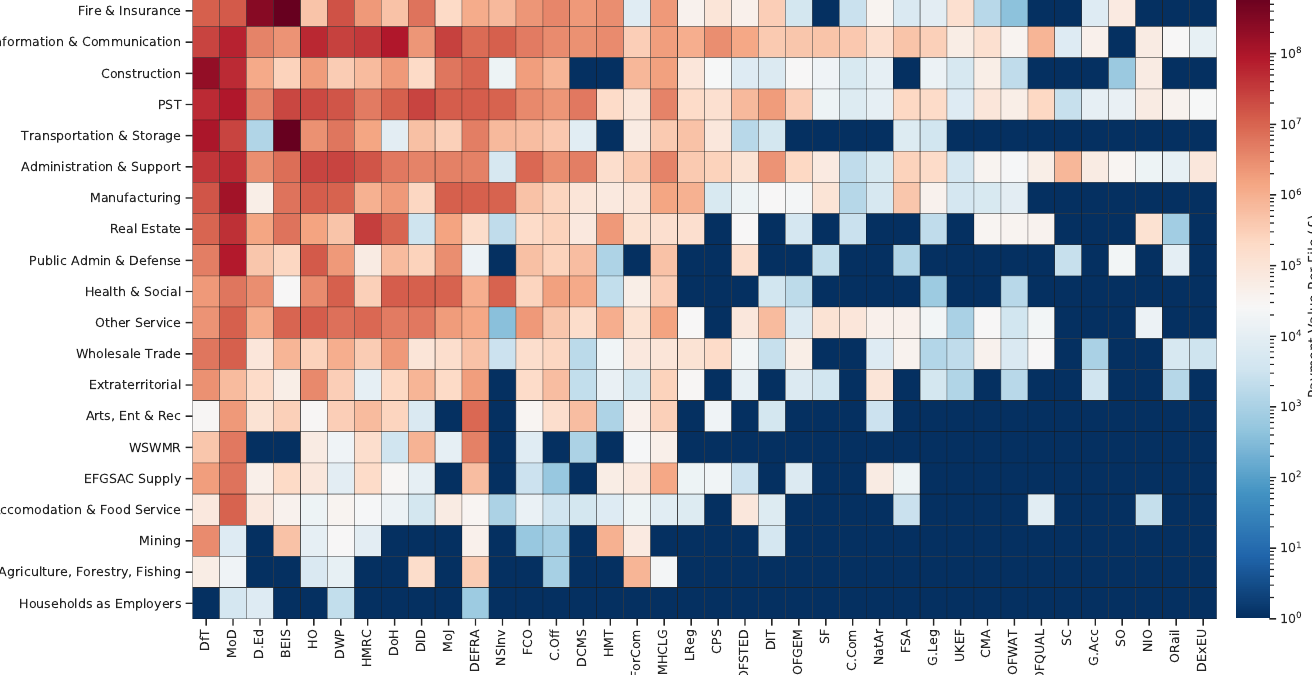
Figure Notes: Standard Industry Classifiers (y-axis) are grouped into higher order aggregate categories, ordered by magnitude of